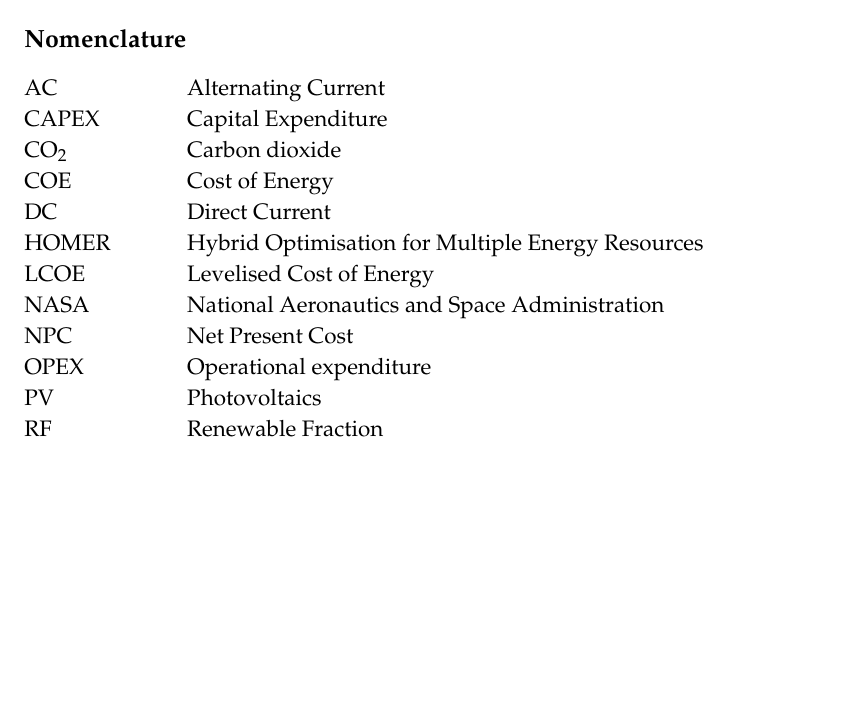
Figure S1. Monthly plots of peak day grid purchases for the base case (System 2) during January-March. Figure S2. Monthly plots of peak day grid purchases for the base case (System 2) during April-June. Figure S3. Monthly plots of peak day grid purchases for the base case (System 2) during July-September. Figure S4. Monthly plots of peak day grid purchases for the base case (System 2) during